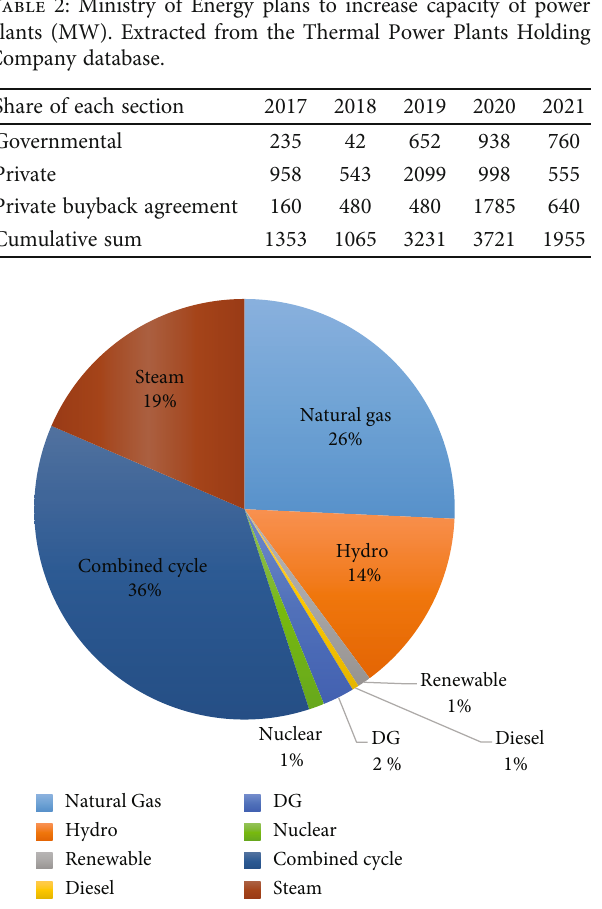
Figure 2: The share of various power plants in electricity generation in Iran. Extracted from the Iran Grid Management Company (IGMC) database.